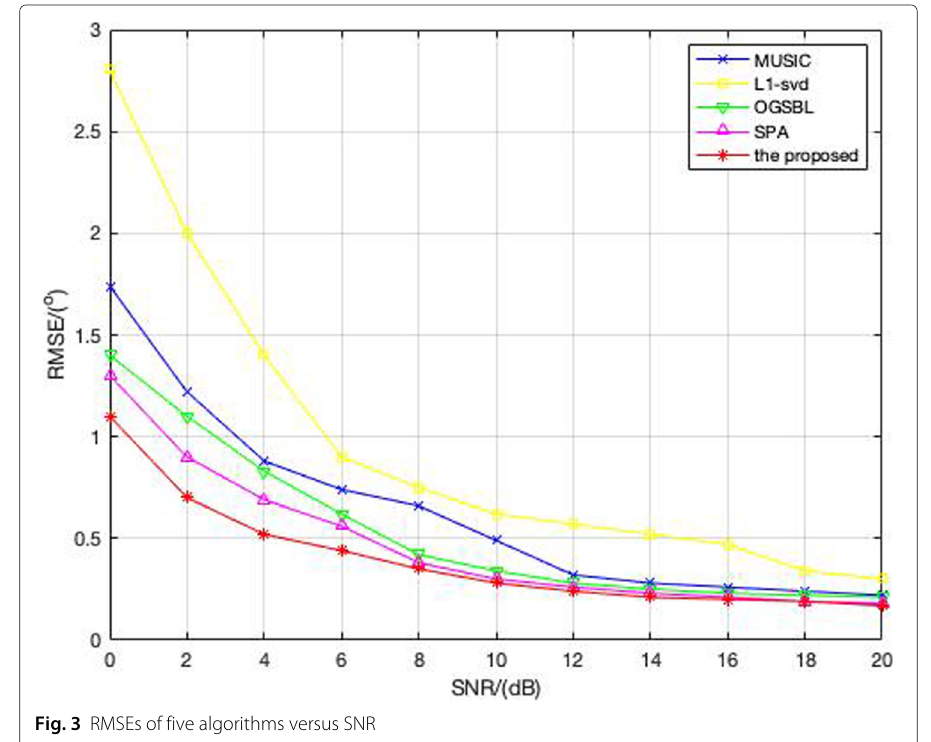
Fig. 3 RMSEs of five algorithms versus